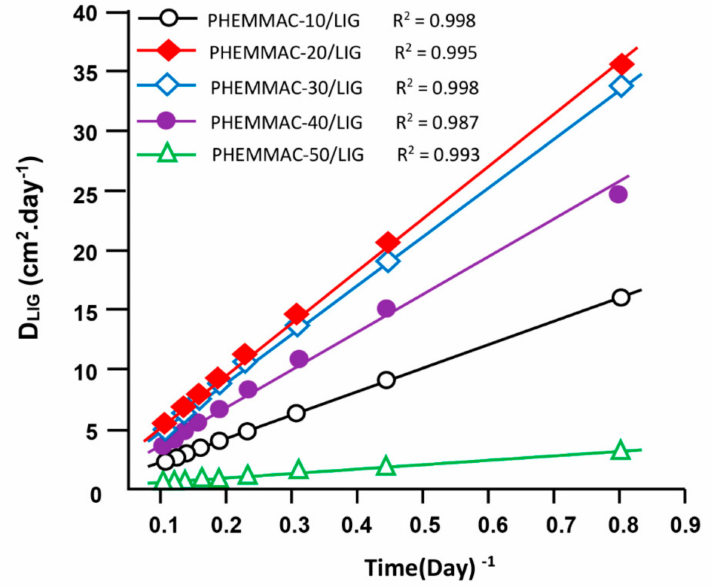
Figure 13. Variation of the di ff usion coe ffi cient of lignocaine through the PHEMMAC / LIG drug-carrier systems with di ff erent MMA contents versus the inverse of